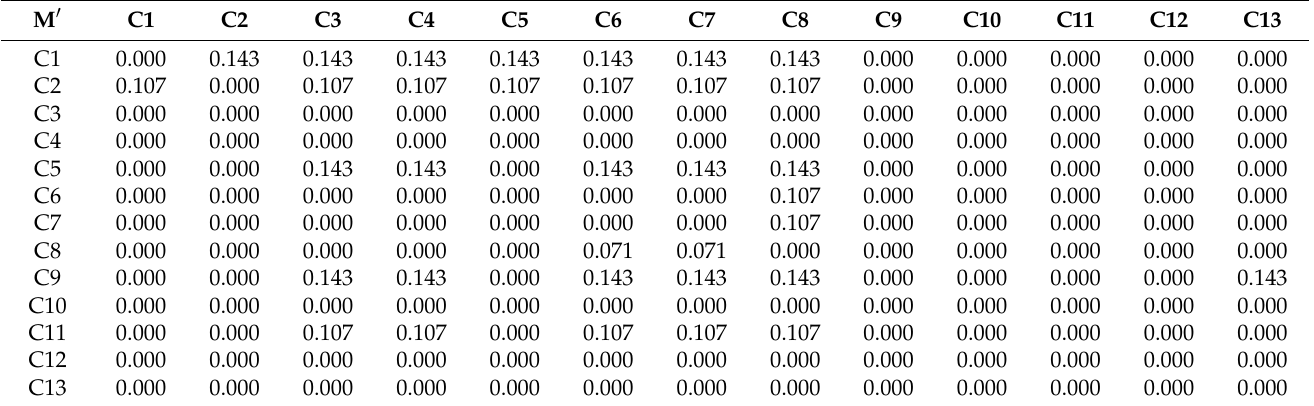
Table 5. Normalized matrix of direct relations M (DEMATEL method).